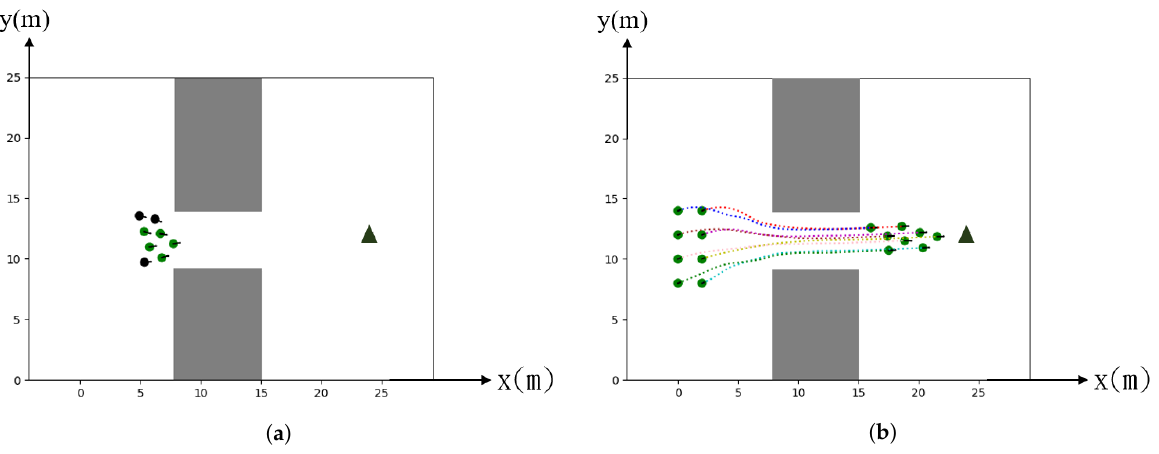
Figure 3. Simulation of trajectories in a narrow passage: ( a ) Waiting state validation, ( b ) All